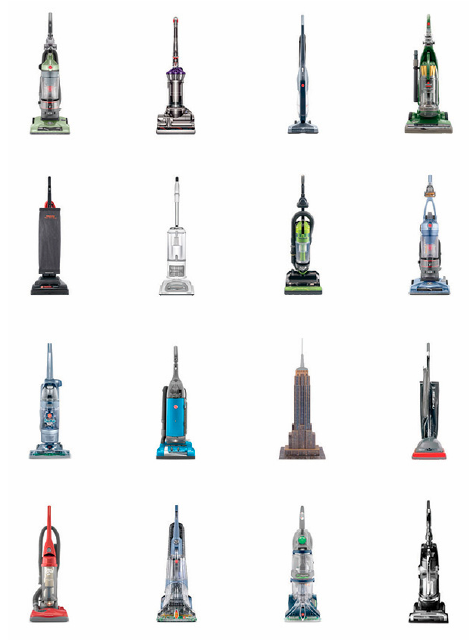
Figure 3. “Seeing as”, A Matter of Arrangements, Pauline Guex, MA Thesis, 2013. Archive Visual Communication Institute, The Basel School of Design HGK